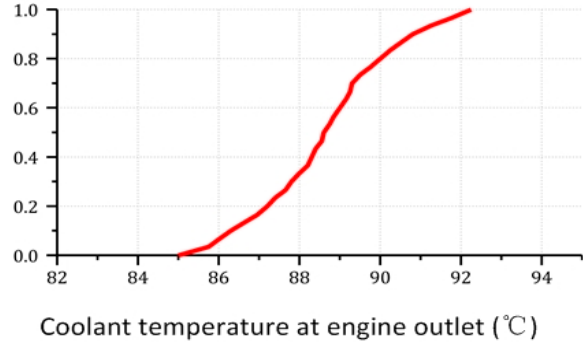
Figure 5. Thermostat valve lift characteristic curve.